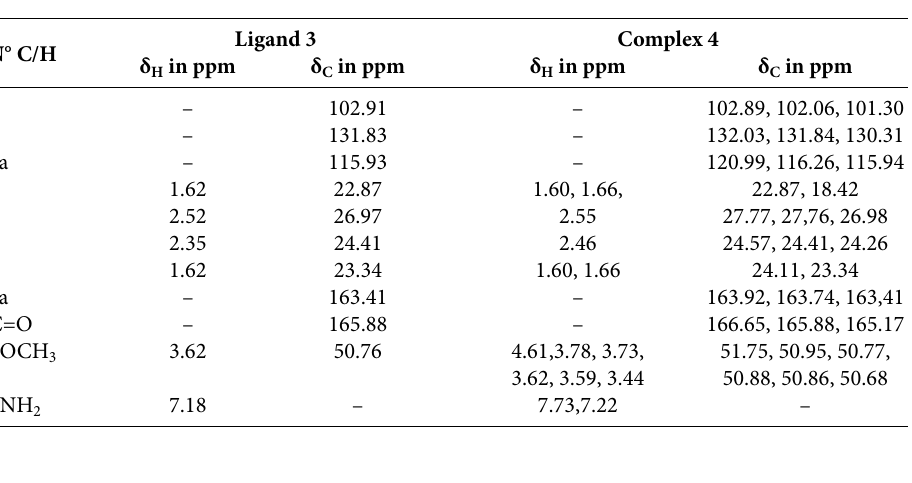
Table 1. Comparison of the 1 H and 13 C NMR (DMSO-d 6 ) chemical shifts of the ligand 3 with those of the complex 4 .